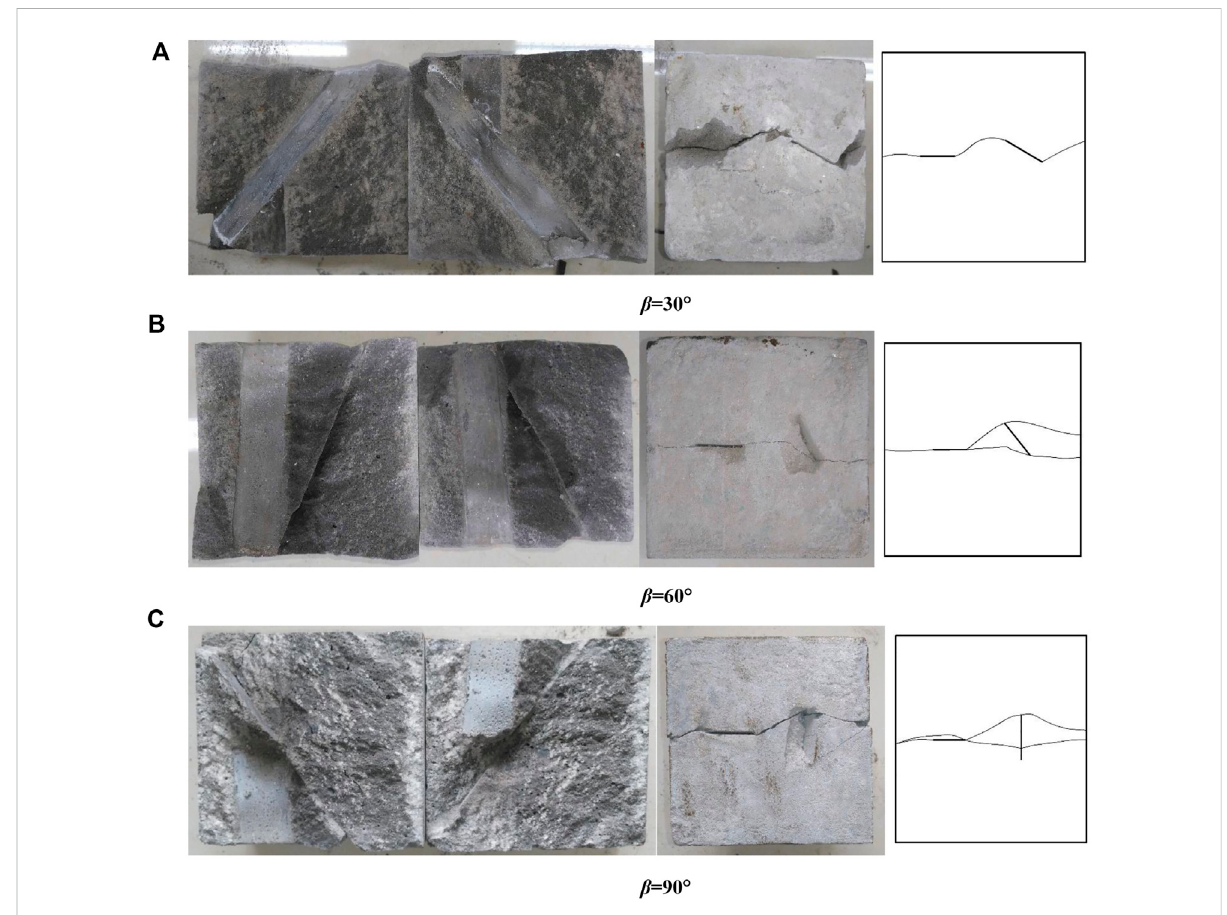
Figure 3, and shear stress and shear displacement are recorded and curves are drawn during the